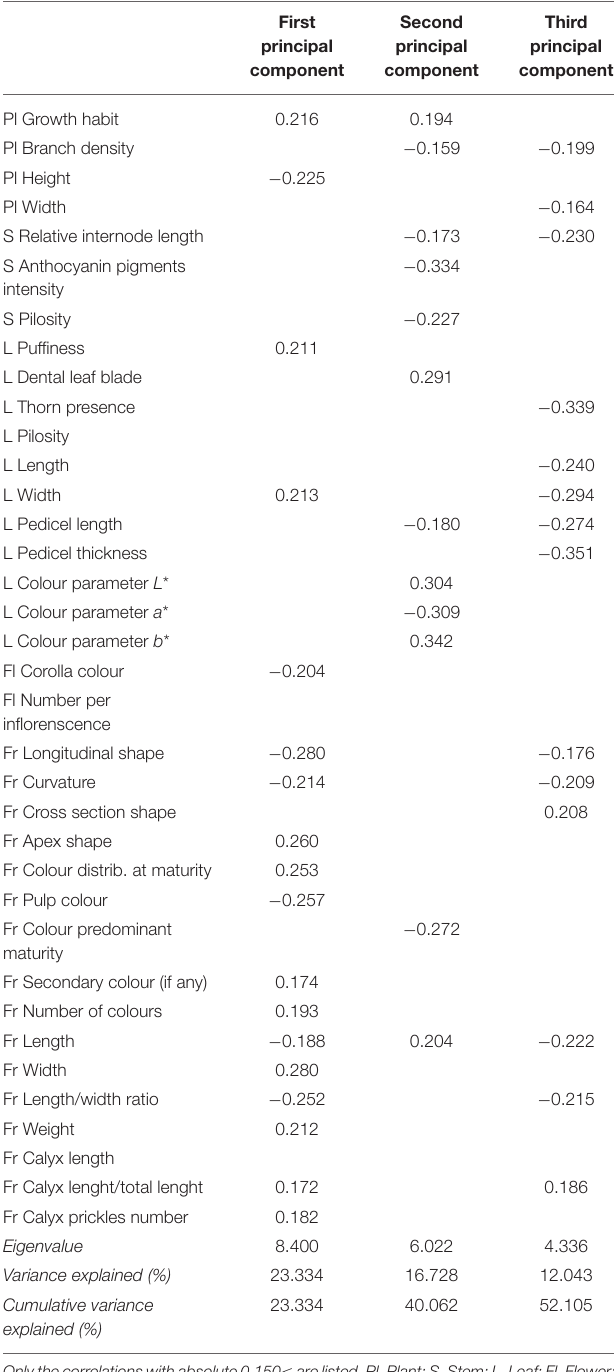
TABLE 3 | Correlation coefficients for each morphological trait for the three first principal components, eigenvalue, and relative and cumulative proportion of the total variance explained by these components in the collection of the 31 eggplant